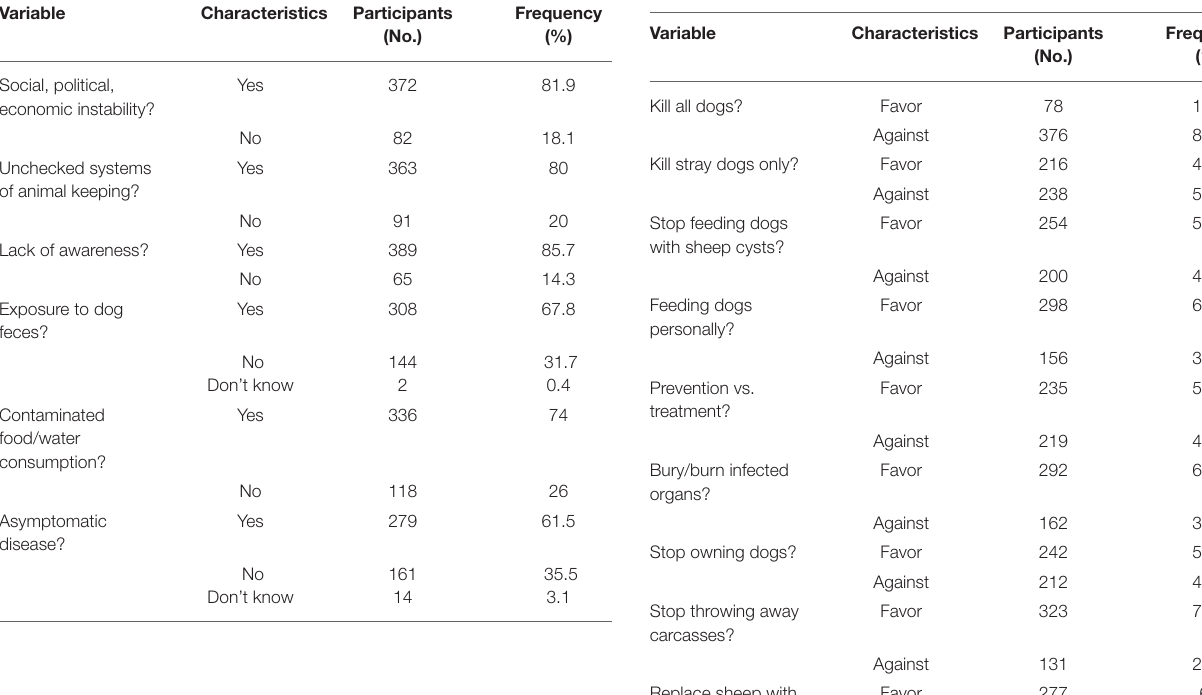
TABLE 5 | Representation of Community perception about CE across different variables. Variable Characteristics Participants